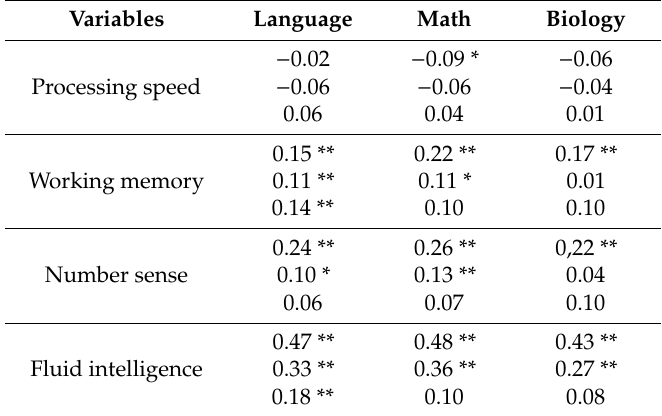
Table 2. Correlations between cognitive abilities and academic achievement at primary (top line), secondary (middle line), and high (bottom line) levels of school education. Variables Language Math Biology − 0.02 − 0.06 Processing speed 0.06 0.01 0.15 ** Working memory